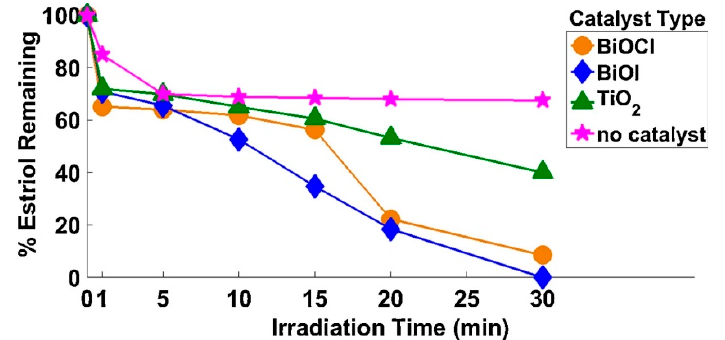
Figure 2. Percent estriol remaining in solution vs. time for estriol in the presence of catalysts under 350 nm light. The readings at time zero do not account for adsorption before exposure to the light source. Reused with permission from reference [12]. Copyright Elsevier 2015.